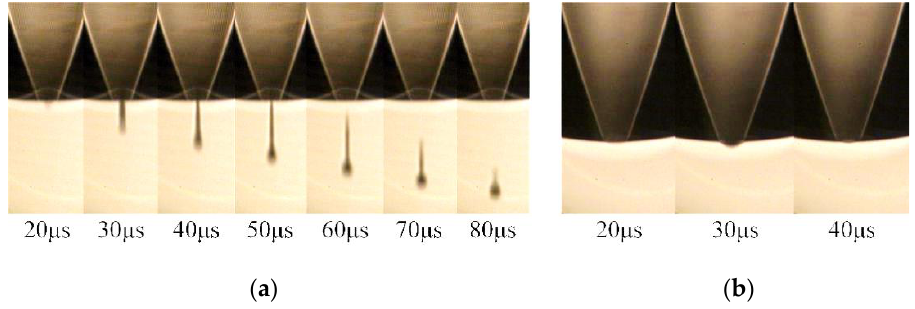
Figure 18. Results of the second set: ( a ) the t f is 1 µs ( b ) the t f is 5 µs. When the t f is 1 µs (the optimized parameters determined by simulation), the ink is squeezed out of the chamber to form a ligament. The ligament then breaks up and forms a droplet with a round head and a slender tail. According to the analysis of the numerical simulation, the appropriate pressure variation allows the printhead to generate droplets that are close to the ideal shape. When the t f is 5 µs, fluctuation in the meniscus at the nozzle occurs during 20 µs to 50 µs. This is because the positive pressure at the nozzle is too small to squeeze the ink out of the nozzle. When the printhead is actuated by the optimized waveform with the t r = 5 µ s, t d = 10 µ s, and t f = 1 µ s, droplets with a slender droplet tail are generated at the noz- zle. Therefore, further optimization of the parameters is required to generate